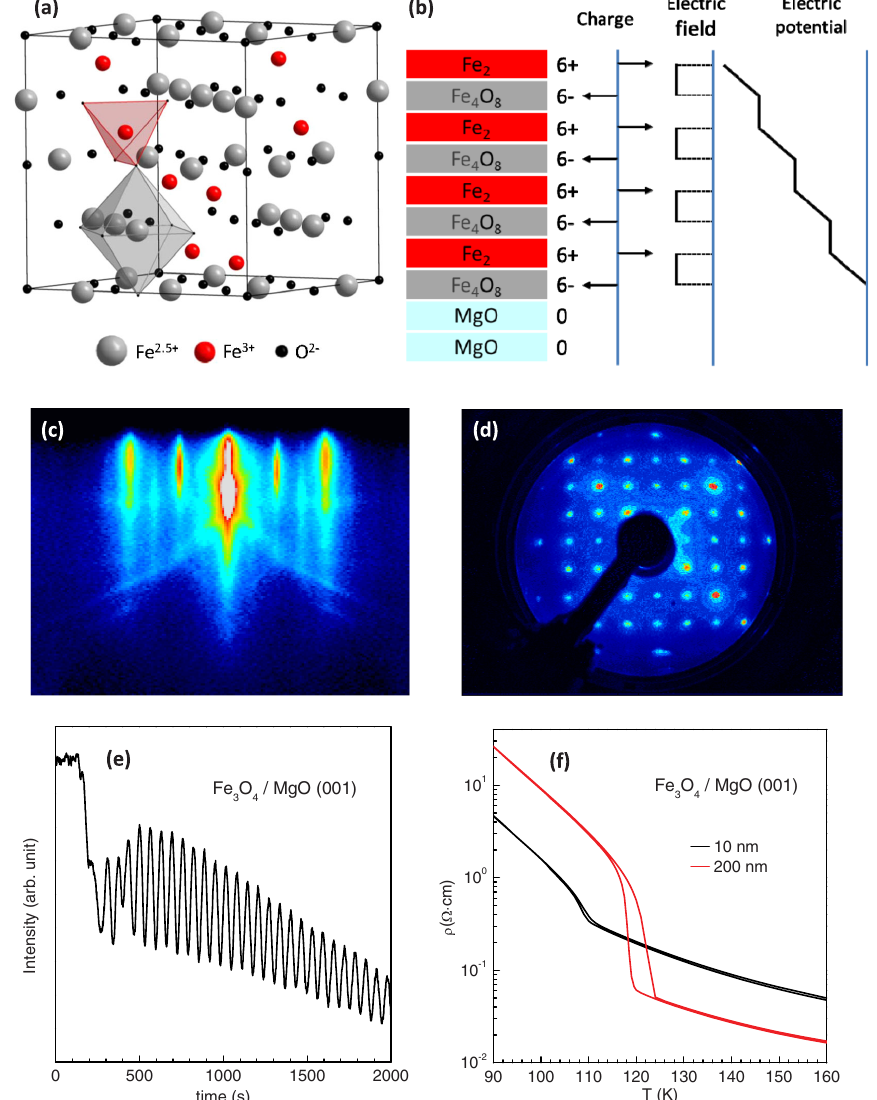
FIG. 1. Fe 3 O 4 on MgO (001). (a) Structure of Fe 3 O 4 . (b) Buildup of the polar catastrophe of Fe 3 O 4 on MgO (001): charged planes, and the corresponding charge, electric field, and electric potential. (c,d) RHEED and LEED patterns, respectively, of a 200-nm epitaxial ffiffiffi p ffiffiffi p 2 2 Þ R 45 ° superstructure. (e) RHEED intensity oscillations of the specularly reflected Fe 3 O 4 (001) film showing the characteristic ð × beam. The electron beam was incident along the [100] direction, with a primary energy of 20 kV. (f) Resistivity as a function of temperature of a 10-nm and a 200-nm thin film, showing the presence of the Verwey